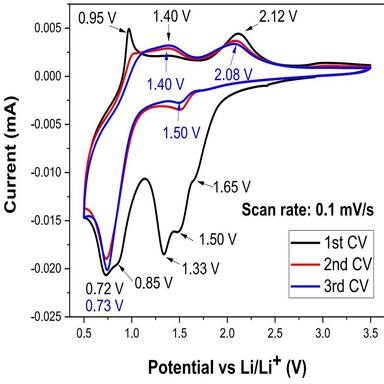
Cyclic voltammograms of Ni3(C8H4O4)3(C3H7NO)4 in a potential window of 0.5–3.5 V, T = 20 °C, 1 M LiPF6 dissolved in EC/DMC (1:1 vol) as electrolyte, Celgard as a separator.